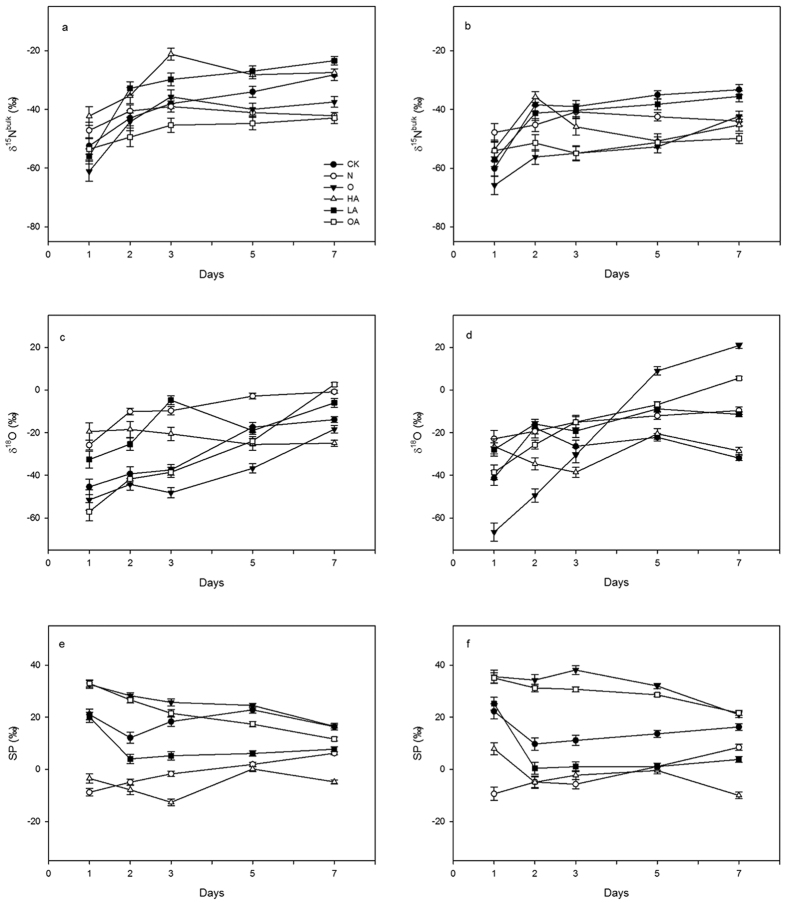
Time series of δ15Nbulk, δ18O, and SP of N2O in different treatments in group A (a,c,e) and B (b,d,f). Error bars represent standard deviation of the mean (n = 3).